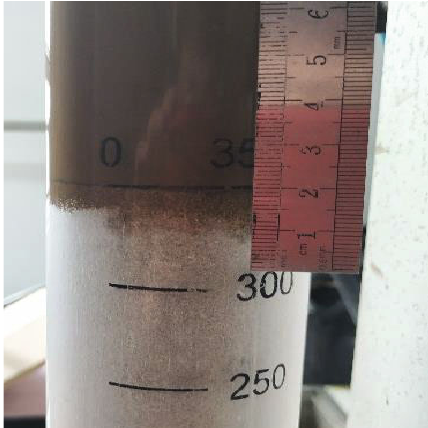
Figure 8: Sealing sand bed test results of strong plugging drilling fl